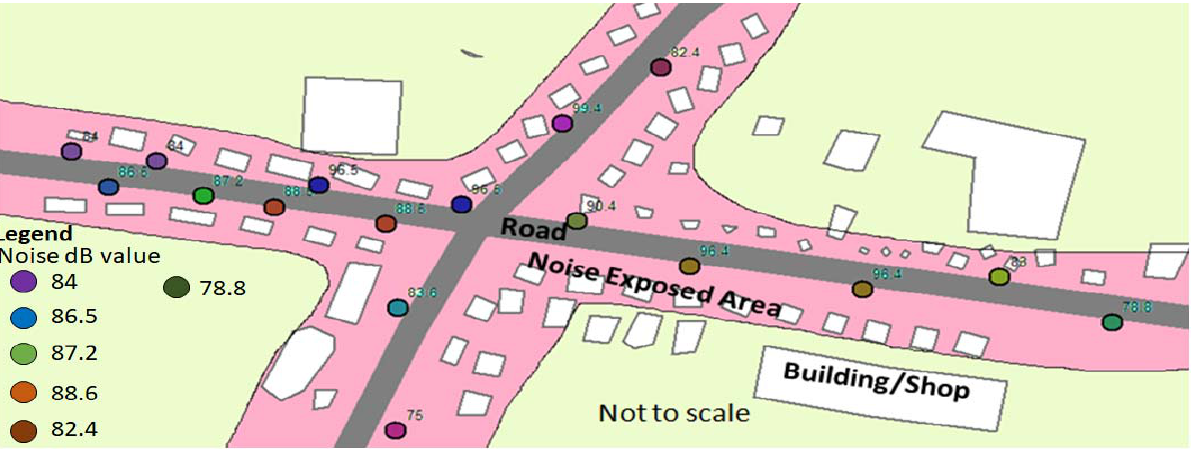
Figure 21. Noise exposure map for short duration at noise value 84.2 dB in event wise at time 9:00–10:30 a.m.